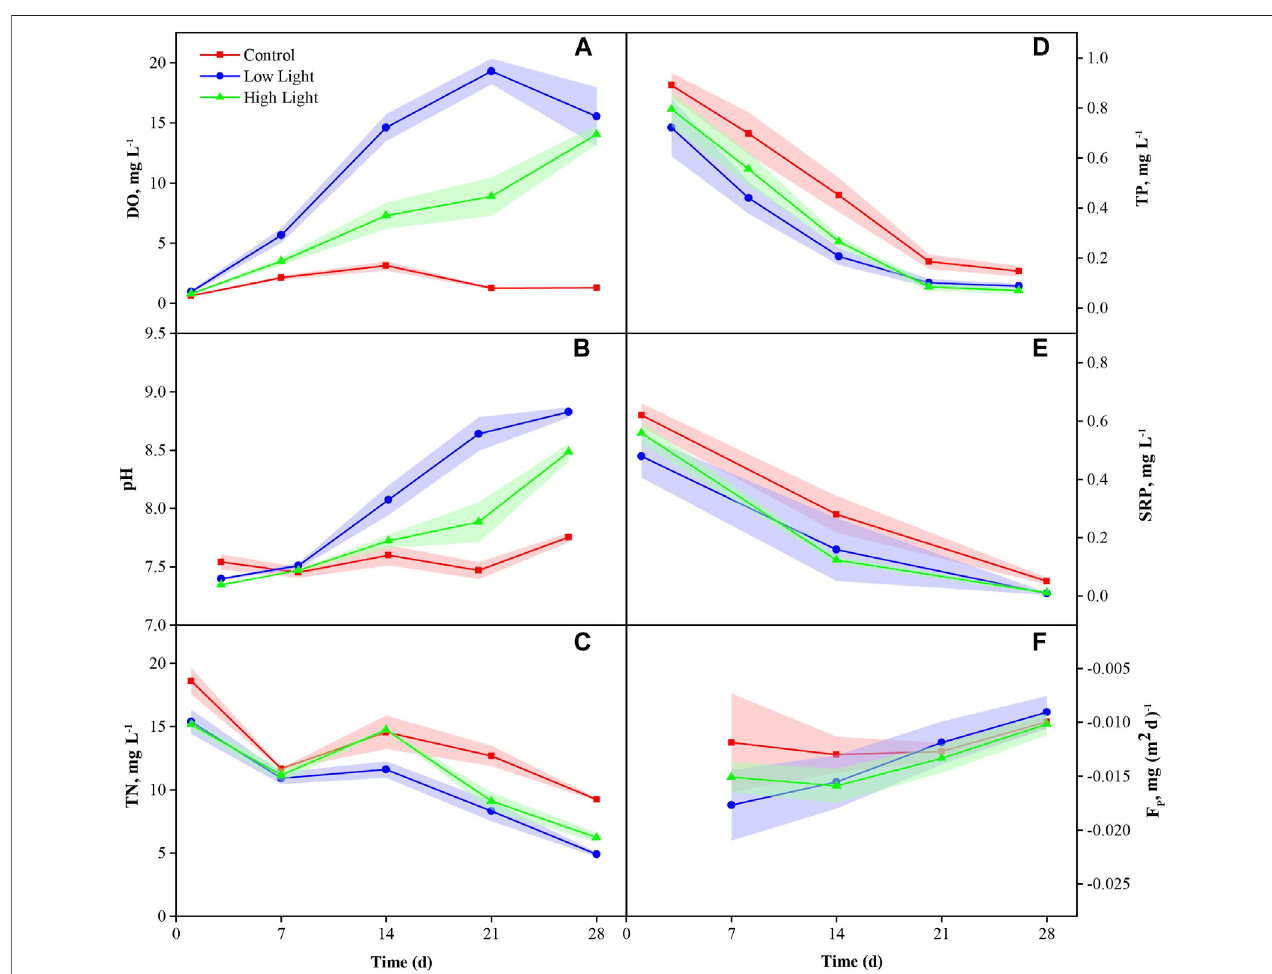
FIGURE1| Dissolved oxygen (DO) (mean ± SE) (A) ,pH (B) , totalnitrogen (TN) (C) , total phosphorus (TP) (D) , soluble reactive phosphorus (SRP) (E) and Prelease fl ux (F P ) (F) in various treatments during the